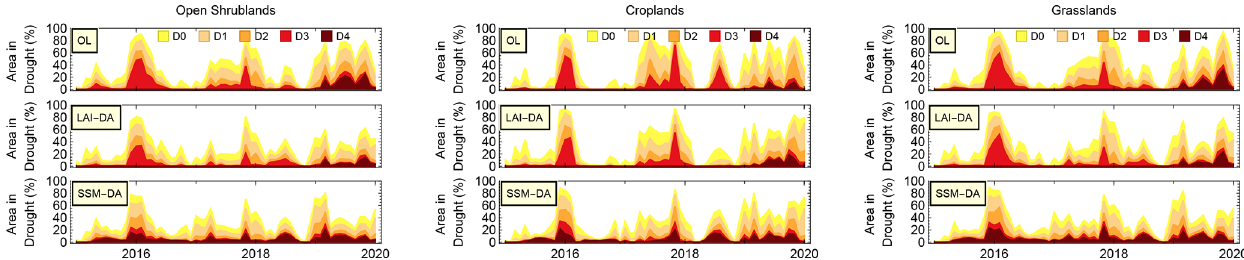
Figure 8. Time series of percentages of area under drought in OL, LAI-DA, and SSM-DA for each root zone soil moisture drought percentile category and for each land use type.